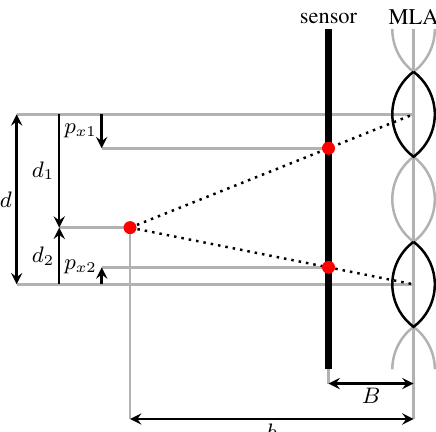
Figure 3: Principle of depth estimation in a Raytrix camera. The distance b between a virtual main lens image point and the MLA can be calculated based on its projection in two or more micro